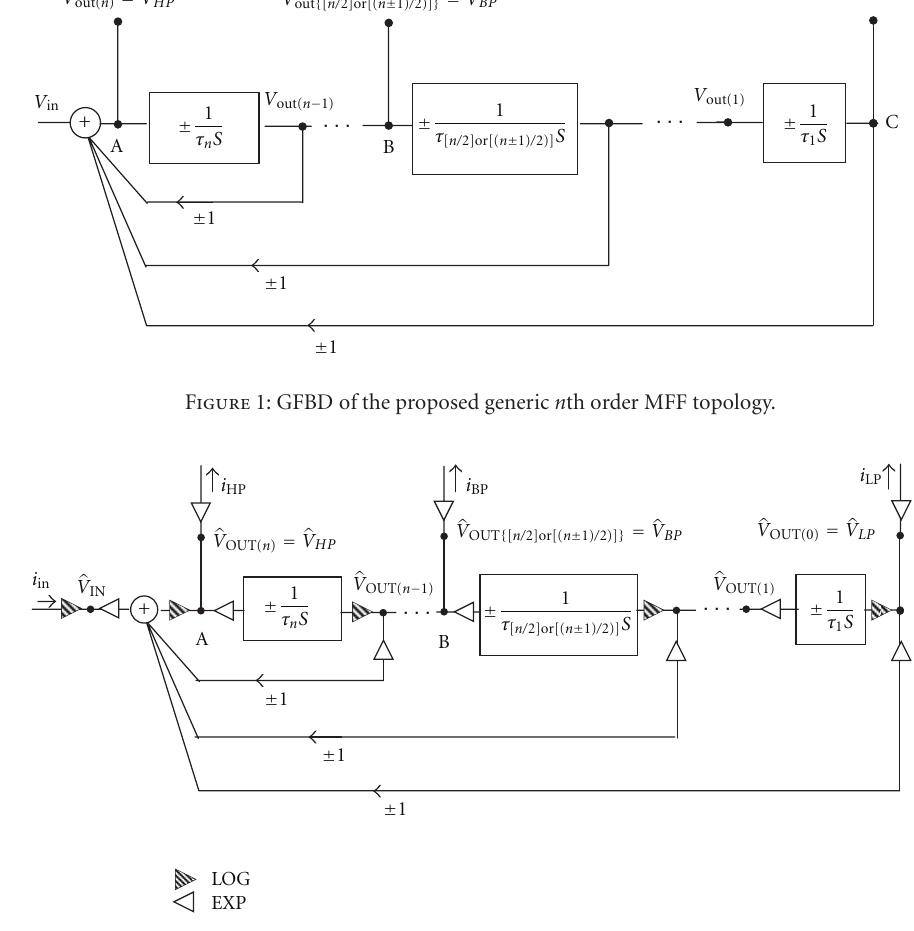
Figure 2: Transposed topology of the filter in Figure 1 into log